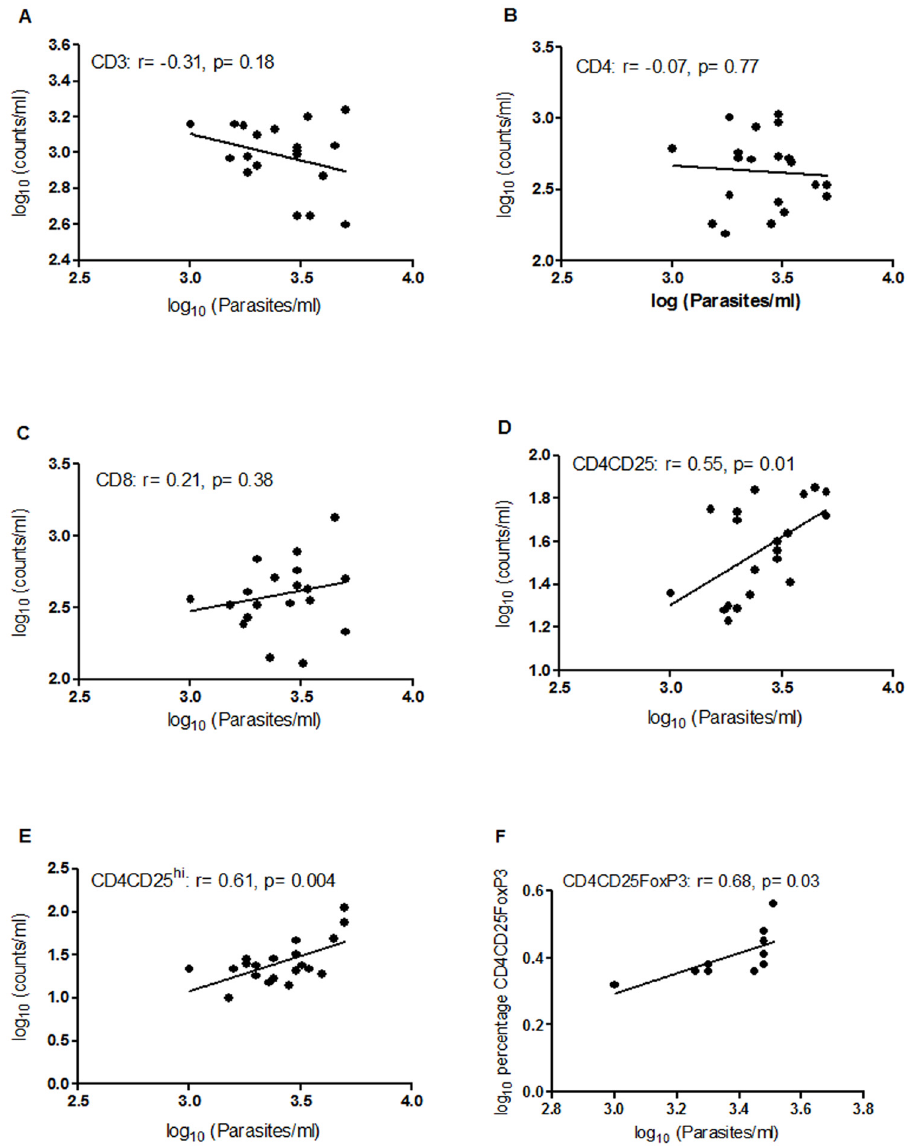
Fig 5. Correlation of different T cell subtypes and CD4CD25FoxP3 with parasite load in VL patients. Absolute numbers of CD3 (panel A), CD4 (panel B), CD8 (panel C), CD4CD25 (panel D), and CD4CD25 hi (panel E) were determined by flow cytometry in whole blood samples of VL patients (n = 20). Percentages of CD4CD25FoxP3-positive cells (panel F) were calculated by flow cytometry in PBMCs of VL patients (n = 10). Parasite loads (Parasites/ml) were determined by real-time PCR. Correlation was calculated using Spearman/Pearson correlation test. Diagonal lines represent linear